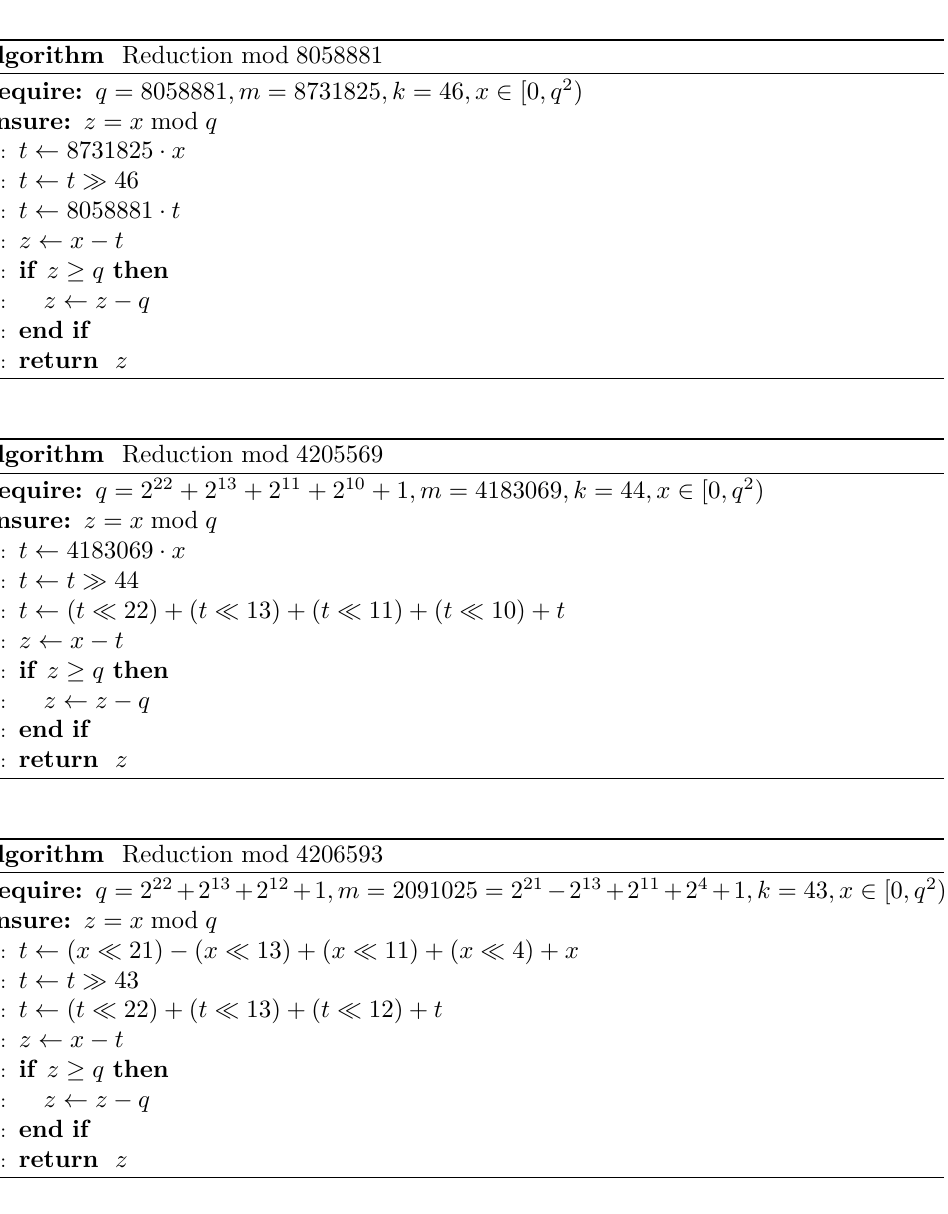
Algorithm Reduction mod